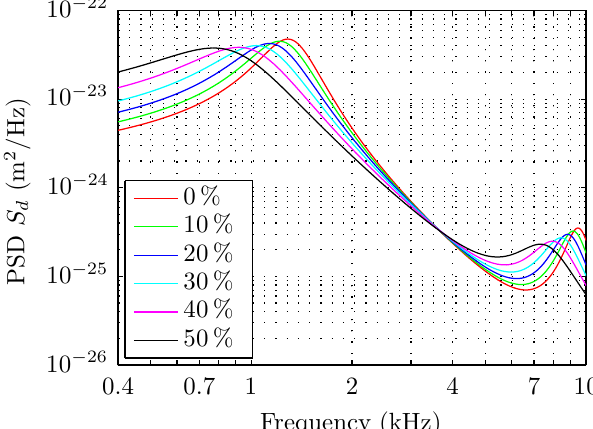
Figure 1. Theoretical curves of PSD of thermal noise-induced deflection of a cantilever for Sader’s model for different glycerol concentrations, at 24 ◦ C ; the corresponding viscosities and densities are listed in Table 1.